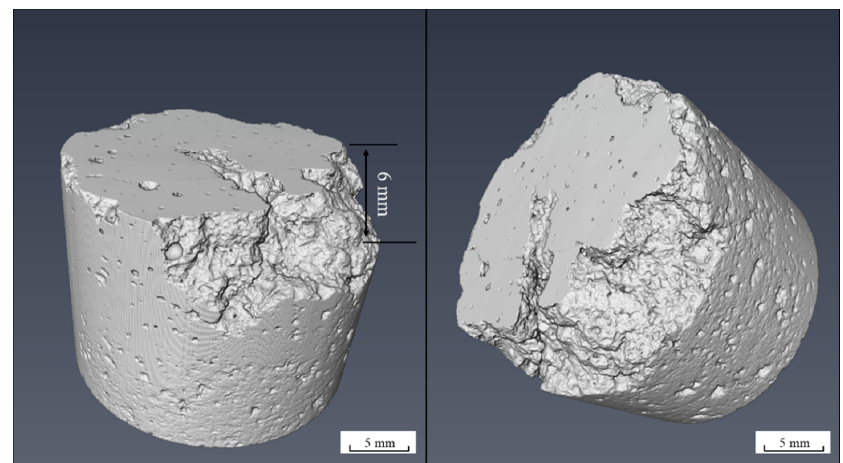
Figure 9. Three-dimensional reconstructed sample.